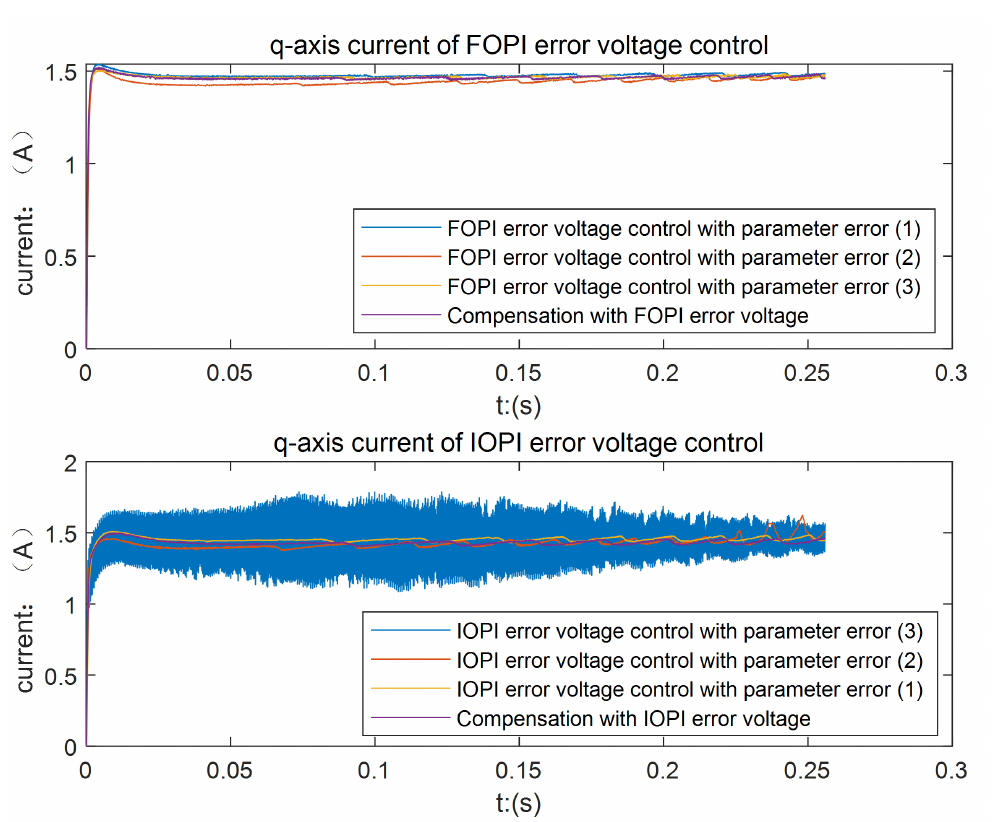
Figure 20. The comparison of I q step current response in the error motor parameters.